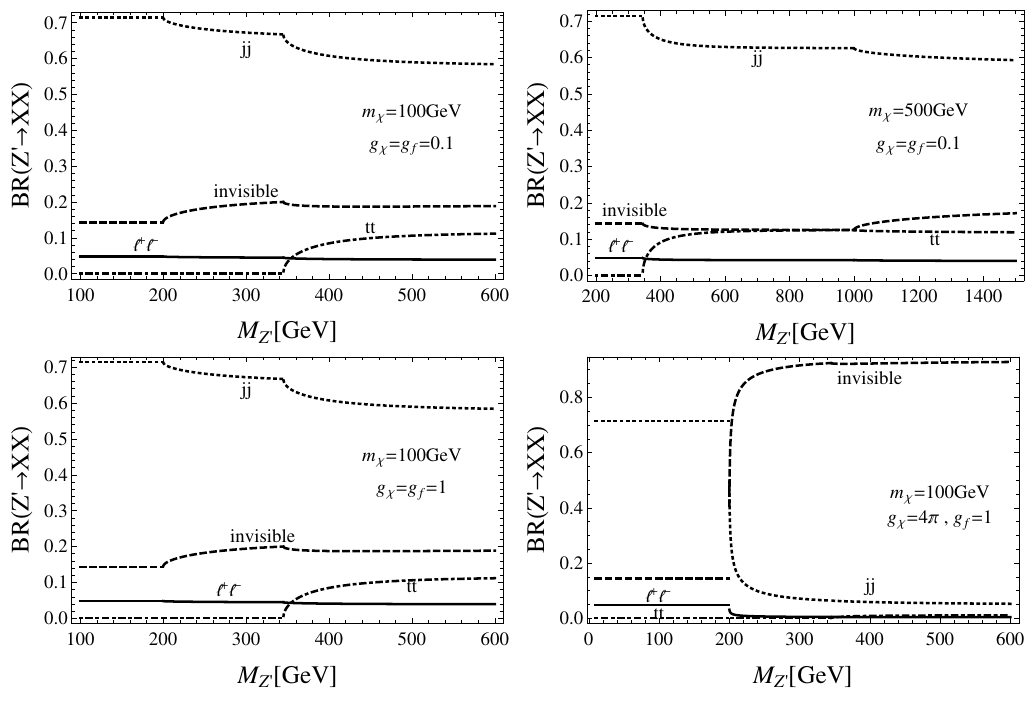
Figure 1 . The Z 0 branching ratios to jets, leptons (electrons, muons or taus), top quarks and invisible (DM and neutrinos), as a function of its mass M Z 0 . We present four scenarios: at the left column we (cid:12)x m (cid:31) = 100 GeV, in the upper(lower) panel the couplings are chosen as g (cid:31) = g f = 0 : 1(1); at the right upper panel we choose a heavier DM with m (cid:31) = 500 GeV and g (cid:31) = g f = 0 : 1, and in the right lower panel we show the branching ratios for an 100 GeV DM, g f = 1 and g (cid:31) = 4 (cid:25) at the boundary of the perturbative